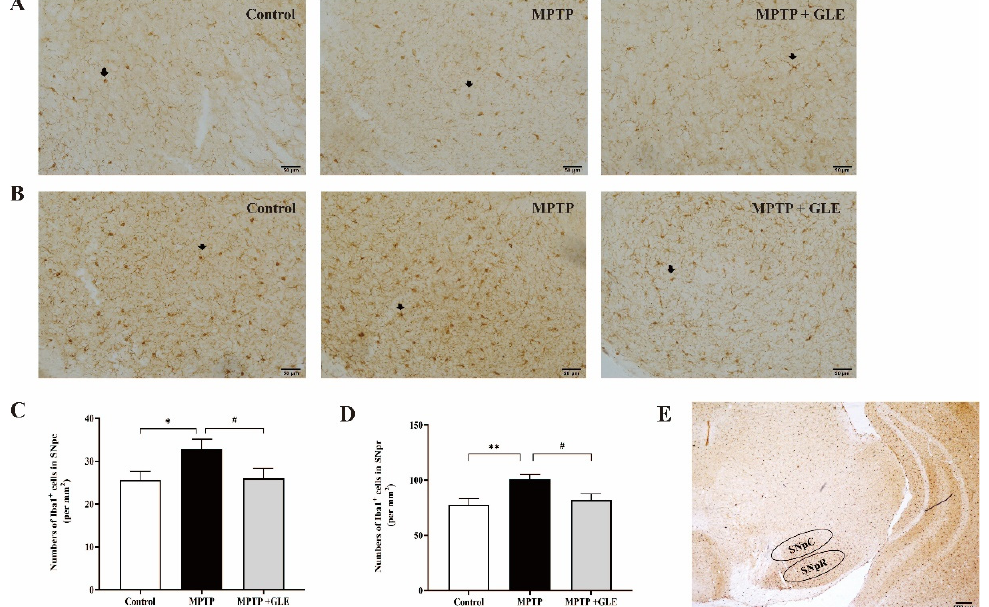
Figure 3. Effect of GLE on the expression of Iba1 in substantia nigra of PD mice. ( A ) and ( B ) Repre- sentative immunohistochemistry images of Iba1 immunostaining in substantia nigra pars compacta (SNpc) and substantia nigra pars reticulata (SNpr), scale bar = 20 um. ( C ) and ( D ) The statistical results of Iba1-positive cells in the SNpc and SNpr of each group, respectively. */**: p < 0.05/0.01, Control group vs. MPTP group; #: p < 0.05, MPTP group vs. MPTP + GLE group. Data are presented as mean ± SEM. Each group n /N ≥ 20 images/5 mice. The arrows stand for Iba1+ cells. ( E ) Diagram of subregion in substantia nigra, scale bar = 200 um.